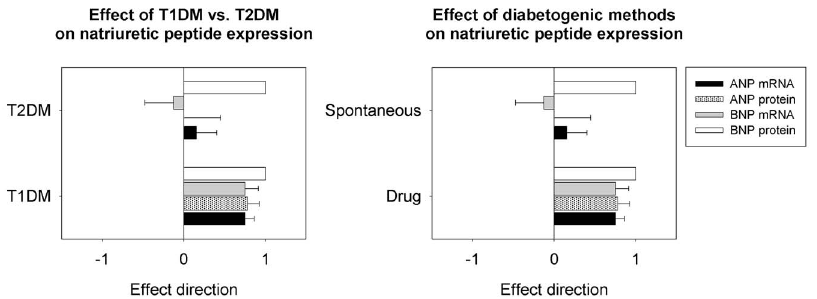
Figure 6. Effect of diabetes type and methods of diabetogenicity on cardiac natriuretic peptide expression. The type of diabetes and the method of inducing diabetes significantly affect the expression of natriuretic peptides in the hearts of experimental rodent models of diabetes.